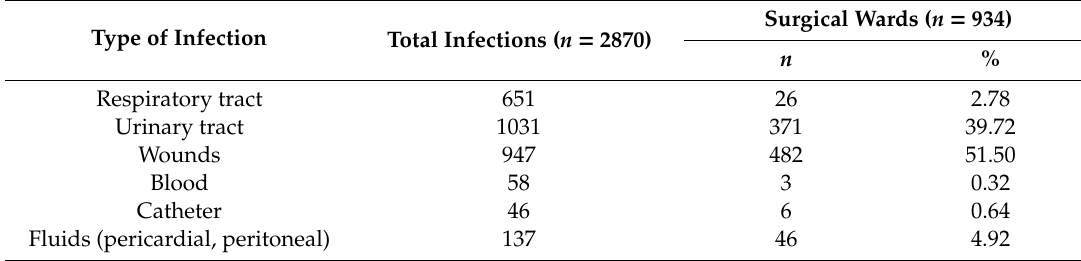
Table 3. Number and frequency (%) of types of